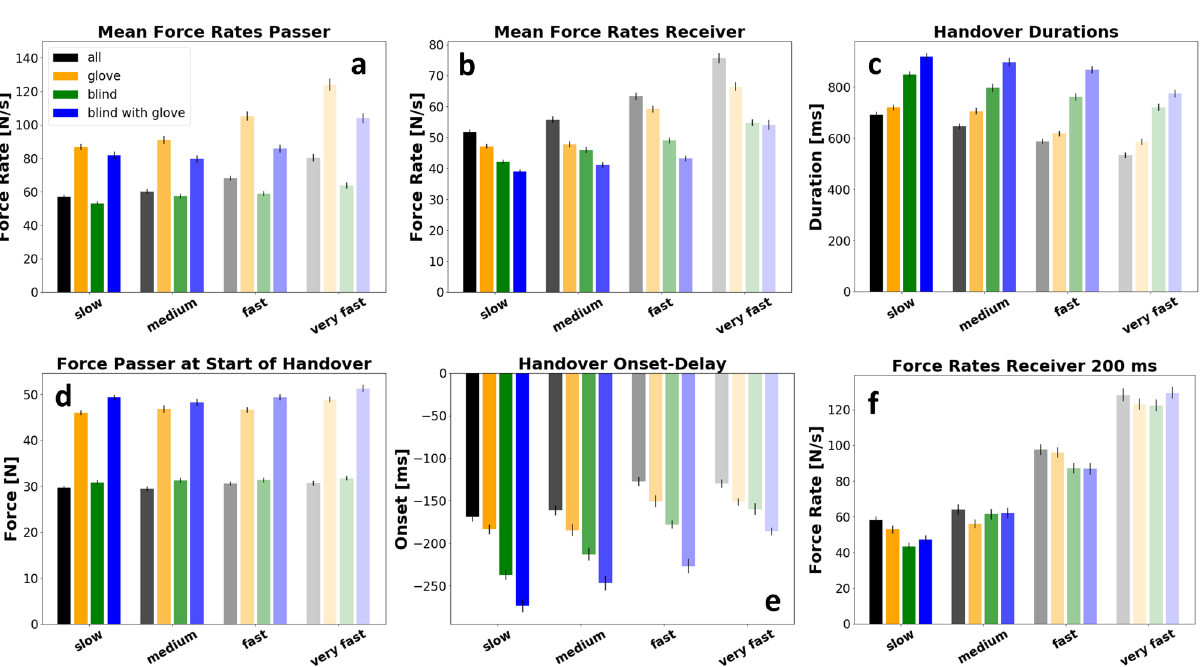
Figure 4. Bar plot for each analysed parameter showing effects from sensory manipulations (colours) and reaching velocity (bar groups). Error bars show standard error of the